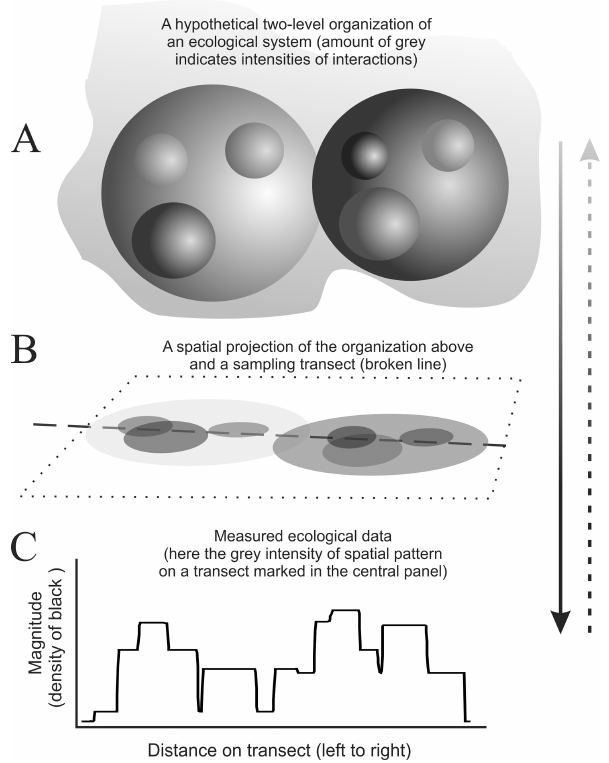
Figure 1. Relationship between entities, their boundaries, and a pattern (of black ink in this case). (A) a hypothetical two-level or- ganization of an ecological system (amount of grey symbolizes in- ternal strength of interactions; (B) spatial projection of the orga- nization above and a sampling transect (broken line); (C) typical ecological data (here the data are density of black pigment on a transect marked in (B) . Note that a progressive loss of boundary discreteness expected in higher level entities is not shown in (C) . The continuous arrow on the right indicates direction of successful mapping. The broken line indicates direction of increasing difficulty (entities become more difficult to identify when one starts with the pattern only). Lighter shading of the line indicates increased ambi- guity. Note that boundaries arise at different levels of organization, which allows for different processes, whether biological or geomor- phologic, to be nested, to overlap, intersect, and to interact in com- plex and specific ways, depending on the system of interest. In this model, the tension between community based approach to bound- aries and those associated with ecosystems (cf. Post et al., 2007) can in principle be reduced, if not entirely